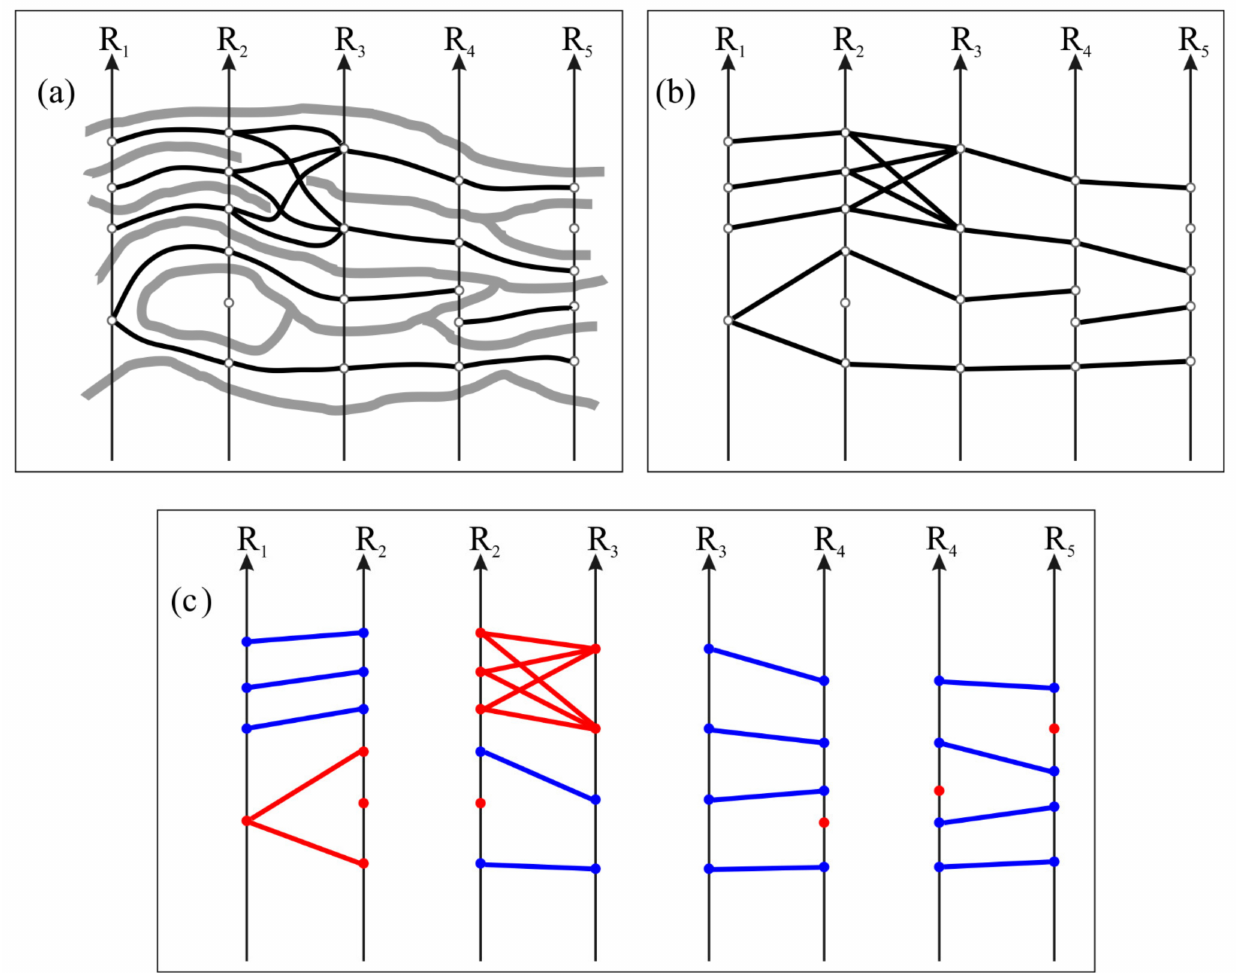
Figure 2. Isotropic and anisotropic layers as building blocks of layered patterns. ( a ) From the anisotropic layered pattern to graph. ( b ) Corresponding graph of an anisotropic layered pattern. ( c ) Isotropic ( blue ) and anisotropic ( red ) edges and vertices of the 5-partite